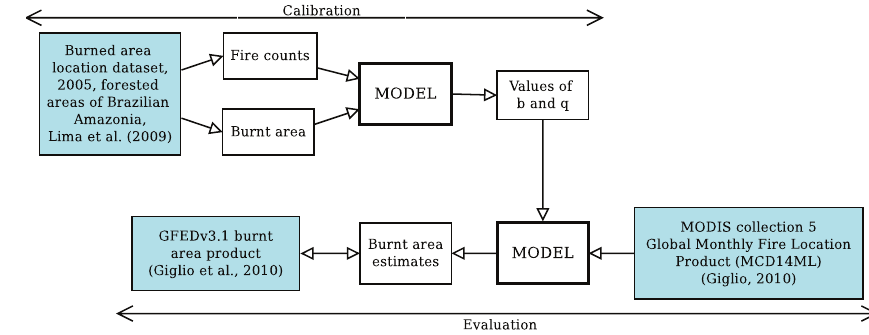
Fig. 1. Flow diagram detailing the data sets and parameters used in calibrating and evaluating the